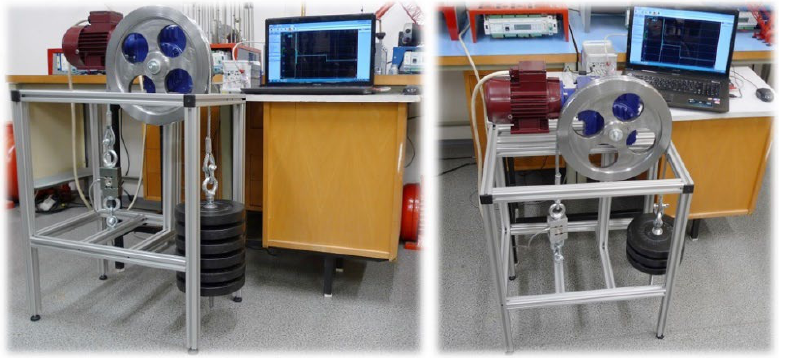
Figure 17. Implementation of a laboratory device used to measure tensile forces in the side of a rope approaching the rope sheave. approaching the rope